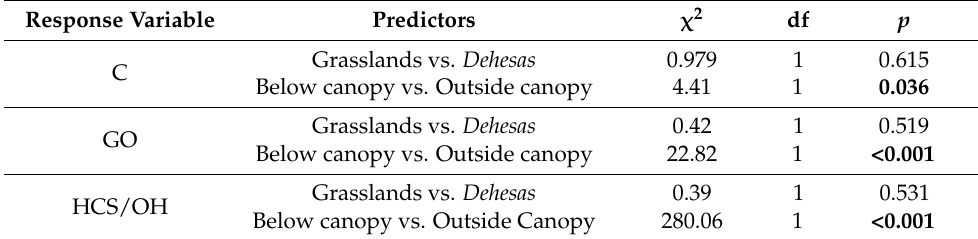
Figure 2. Graph depicting the number of species of soil nesting ants collected per pitfall trap ( mean ± SE ) in: (i) grasslands and dehesas (Figure 2a) and (ii) below and outside tree canopies within dehesas (Figure 2b). Different colors represent the different functional groups (C = cryptic species, GO = generalists and/or opportunists and HCS/OH = specialists in warm and/or open habitats). Table 2. Differences between habitats (grasslands vs. dehesas ) and between microhabitats (below and outside oak canopies within dehesas ) in the number of species of the different functional groups (C = cryptic species, GO = generalists and/or opportunists and HCS/OH = specialists in warm and/or open habitats). Significant p -values are shown in bold.